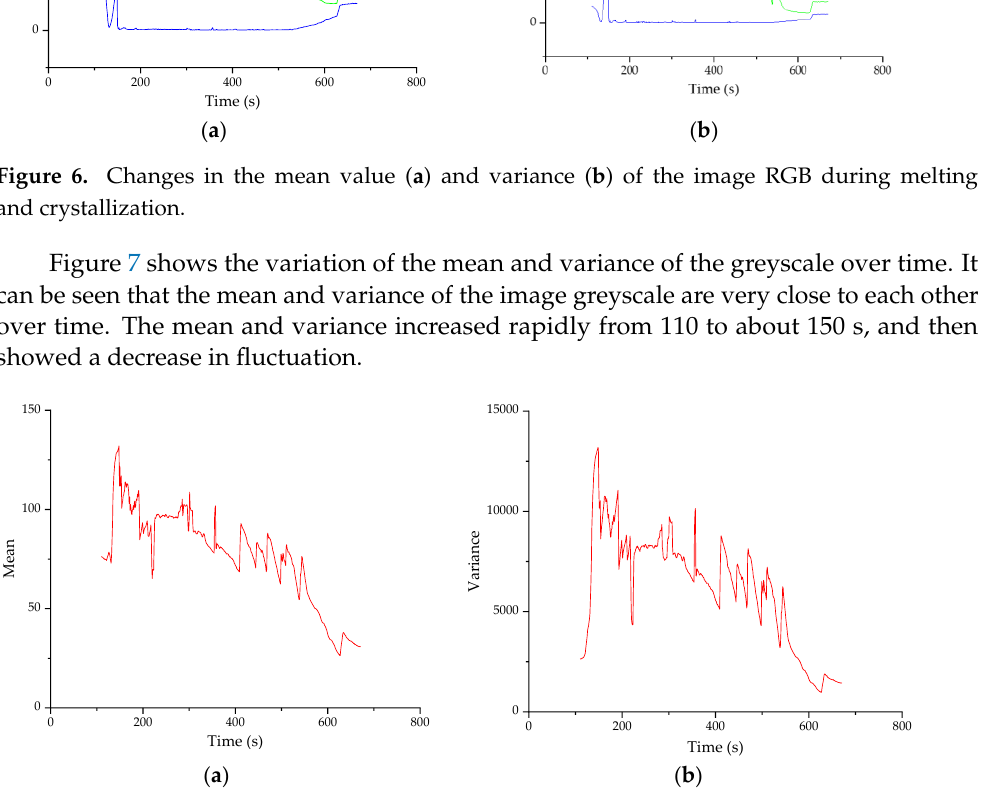
Figure 7. Changes in the mean value ( a ) and variance ( b ) of greyscale during melting and crystalli- zation.